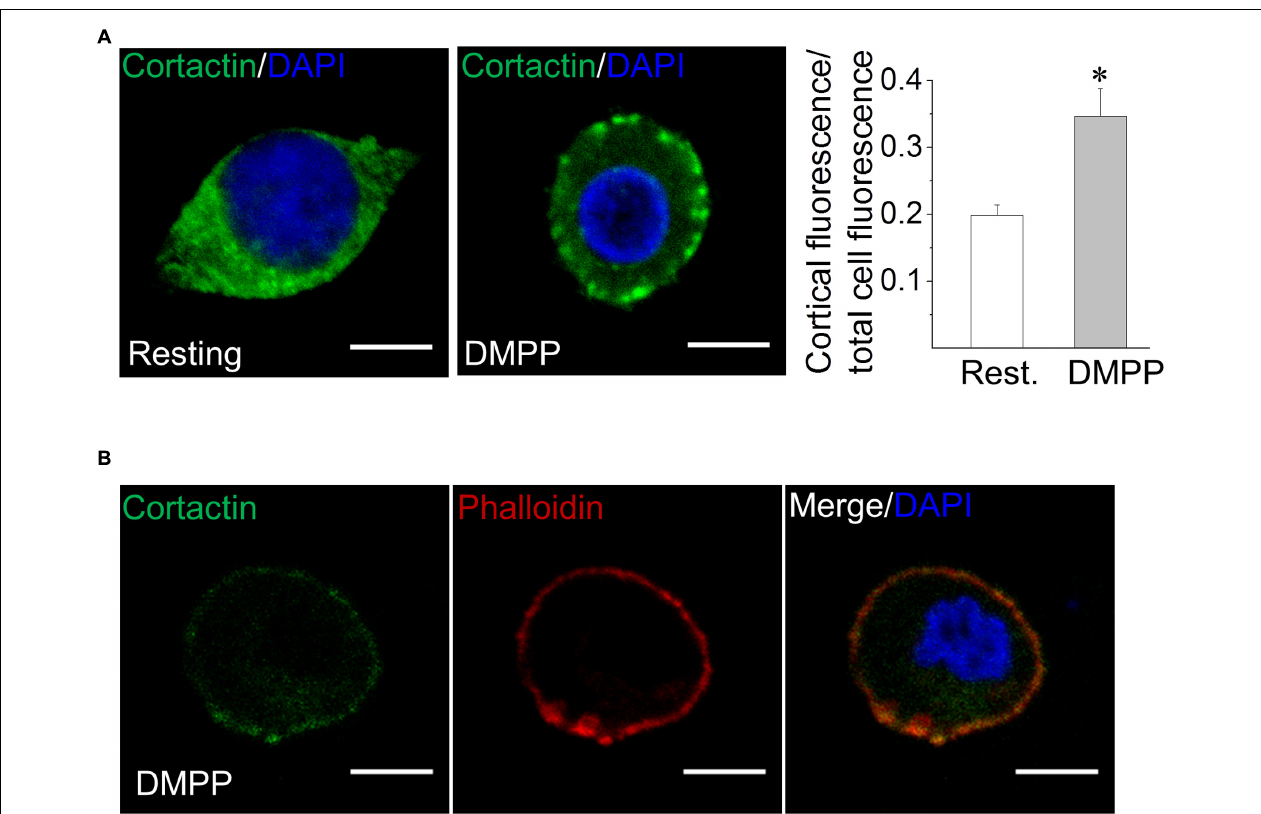
FIGURE 1 | Cortactin migrates from the cytosol to the cell cortex in response to stimuli that induce exocytosis. (A) Bovine chromaffin cells under resting condition or stimulated with the nicotinic agonist DMPP (50 µ M) were immunolabeled with an anti-cortactin monoclonal antibody (green). Nuclei were stained with DAPI (blue). The relative labeling of cortactin in the cell cortex was quantified by dividing the cortical fluorescence intensity (1 µ m under the cell periphery) by the total cell fluorescence intensity. Note that cell stimulation with DMPP significantly increased the cortical localization of cortactin as compared to the resting condition. ∗ p < 0.05 (one-way ANOVA followed by unpaired t -test). Scale bar = 10 µ m. (B) Cultured chromaffin cells were DMPP-stimulated, fixed and co-labeled with an anti-cortactin-directed antibody (green) and the F-actin-binding toxin phalloidin-TRITC (red). Nuclei were stained with DAPI (blue). Then sample were visualized by confocal microscopy. Cortactin/F-actin colocalization was determined by Pearson’s correlation coefficient reaching a value of 0.61 ± 0.05 from five different cultures. Scale bar = 10 µ